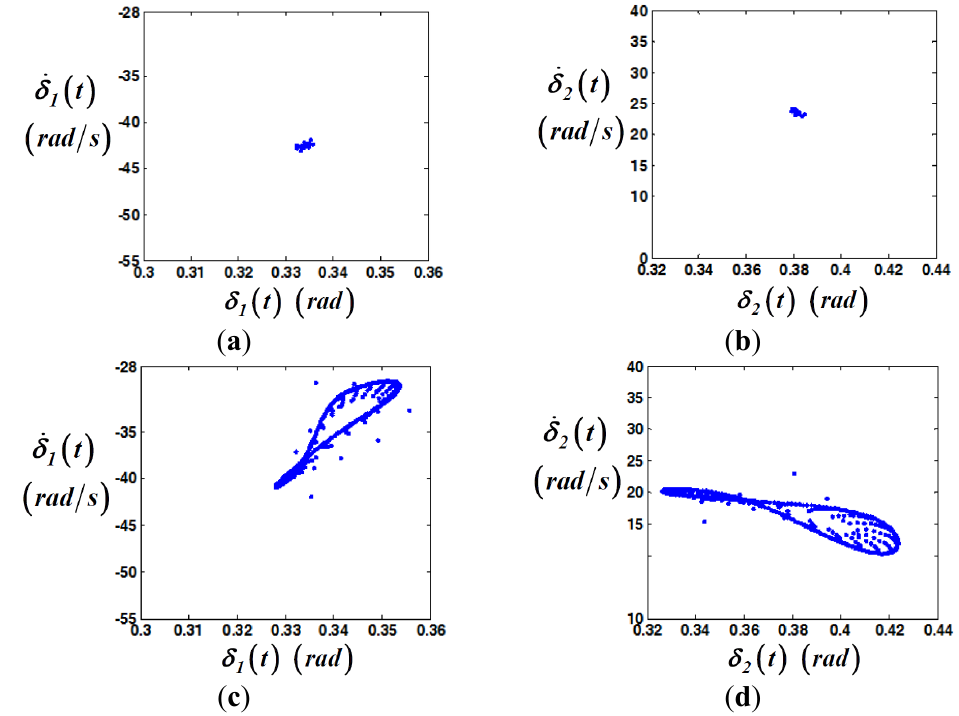
Figure 14. Comparison of Poincaré maps at different excitation conditions: ( a ) Poincaré t  vs.   t   at  = 1.25; ( b ) Poincaré map with   map with   1 1  = 1.25; ( c ) Poincaré map with   t  vs.   t   at  = 1.35; and ( d ) Poincaré map with 1 1   t  vs.   t   at  = 2 2